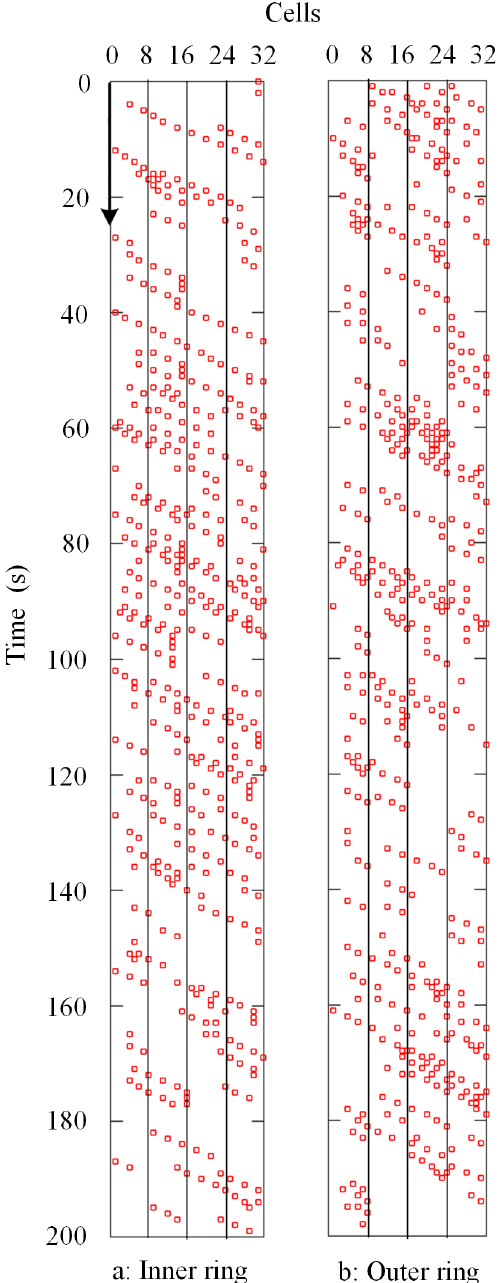
Figure 4. Time-space plots for the inner ring and outer ring with a = 0.05 and Q (cid:5) 720 veh/h.